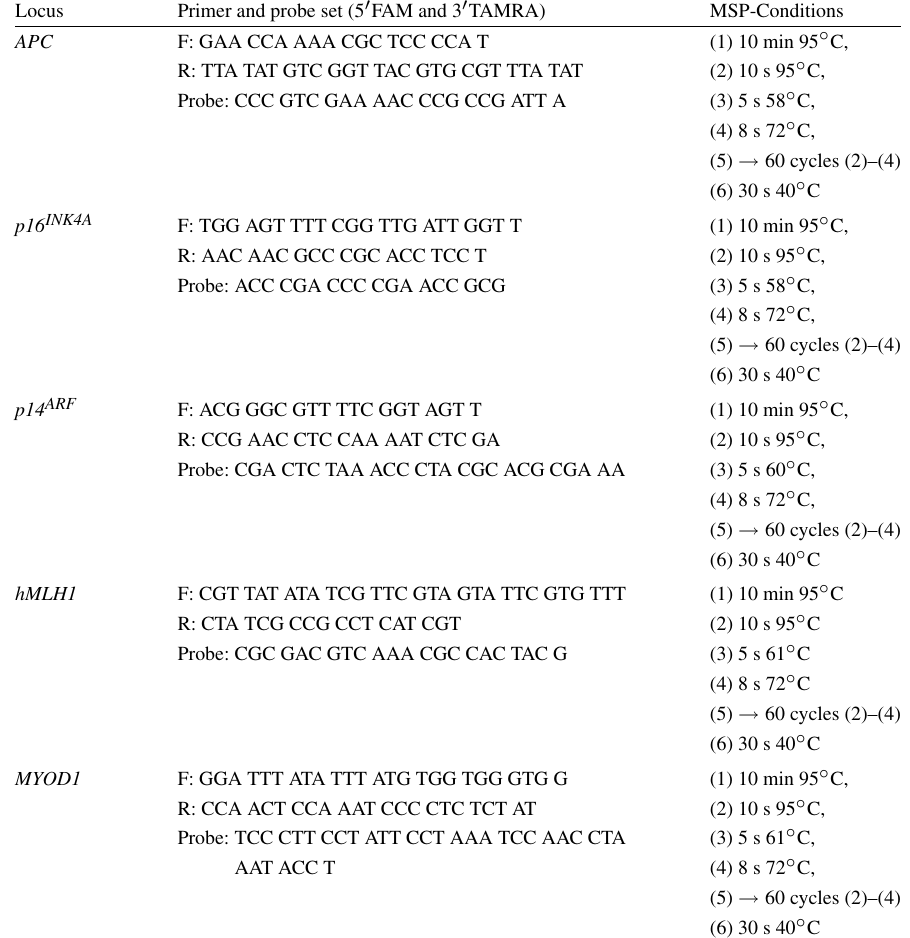
Sets of primers and probes for the investigated gene loci and conditions of methylation-specific PCR (MSP) Locus Primer and probe set (5 (cid:3) FAM and 3 (cid:3)